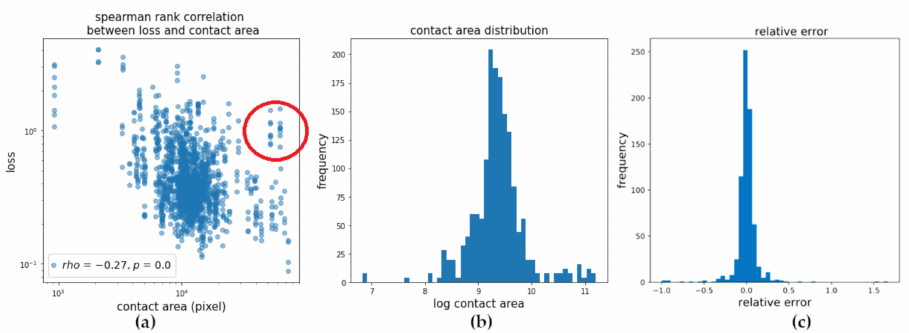
Figure 10. ( a ) Dependency between validation loss and contact area. We found weak, but significant ( p < 1 × 10 − 27 ) negative Spearman rank correlation as well as a cluster of high-contact-area samples with comparably high losses (marked by red circle). ( b ) Contact area distribution in the training data. ( c ) Distribution of the relative error between target area and predicted